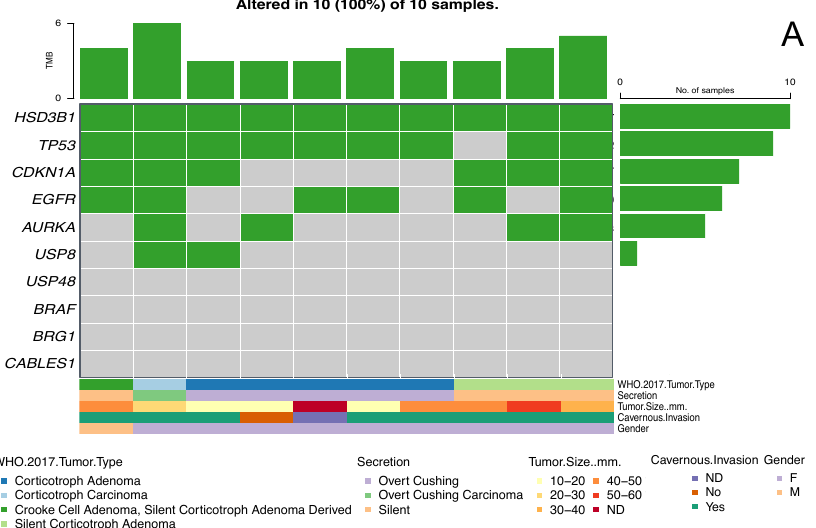
Altered in 10 (100%) of 10 samples.